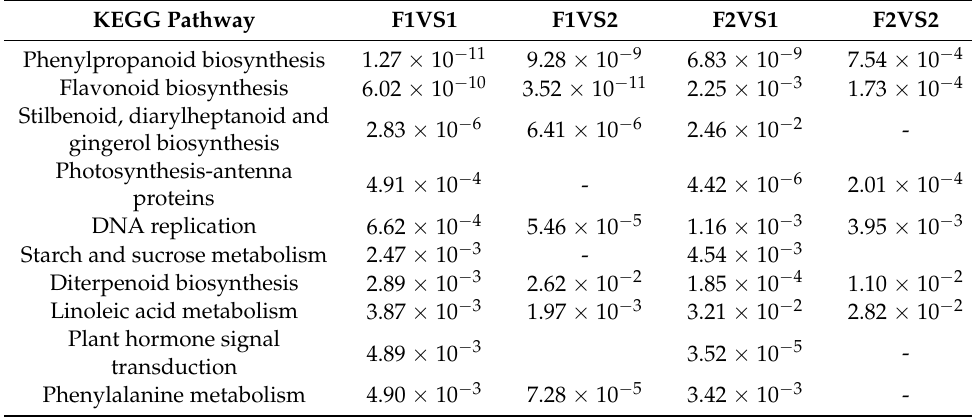
Table 2. The top KEGG pathways enriched by upregulated